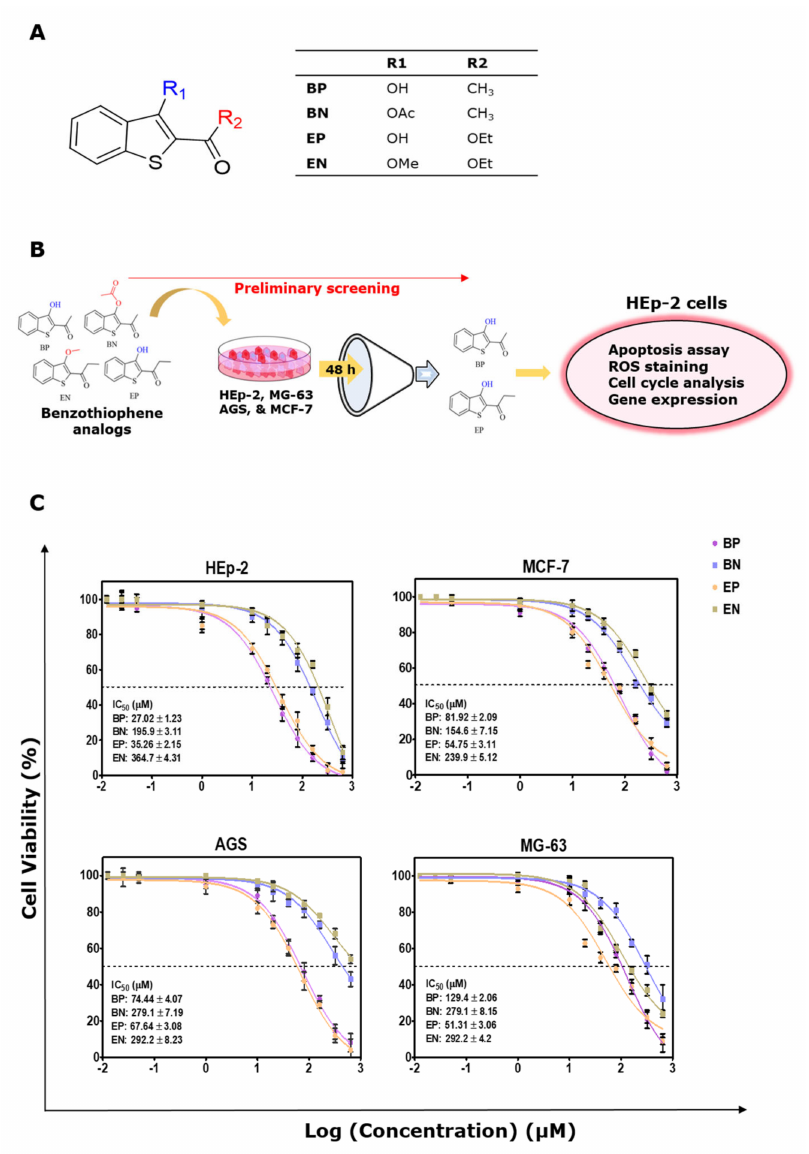
Figure 1. ( A ) Structure of the benzo[b]thiophene analogs. ( B ) Experimental outline of this study. ( C ) Logarithmic dose–response curves of Benzo[b]thiophene analog treatment in human